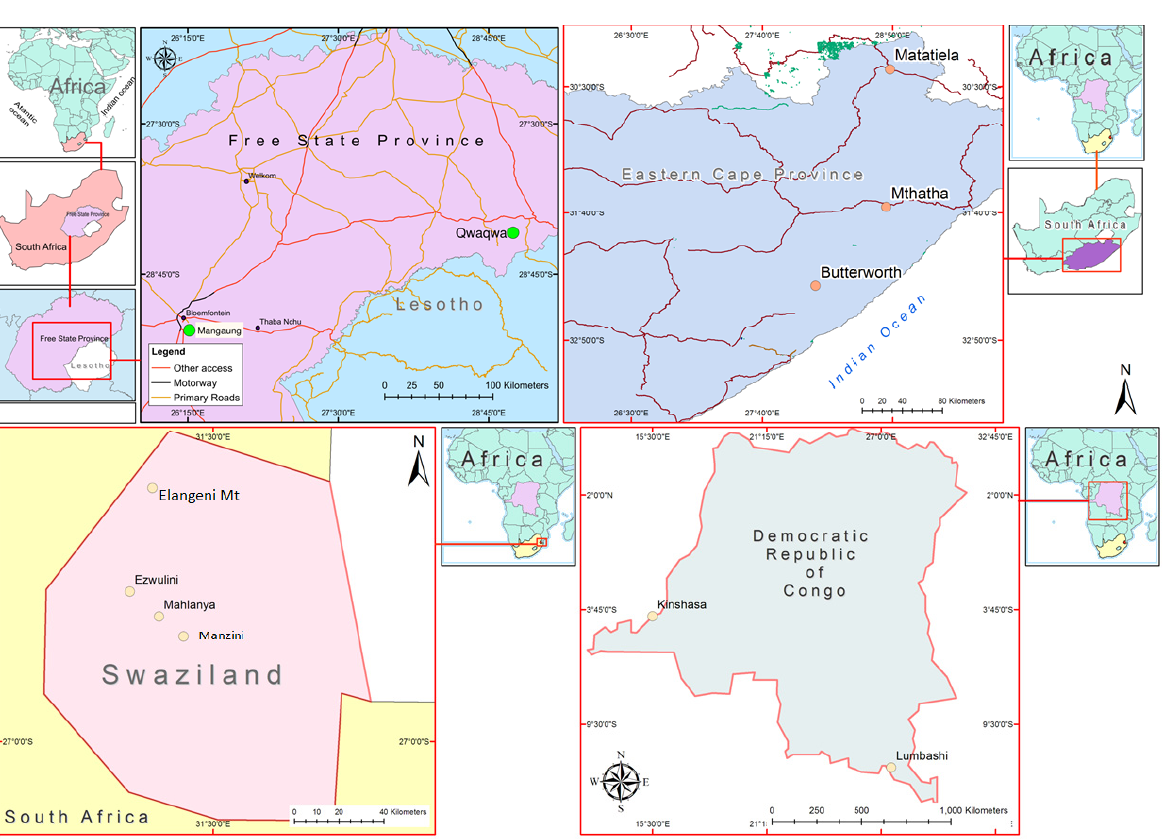
Figure 1. Map showing location of sampling points in the three different